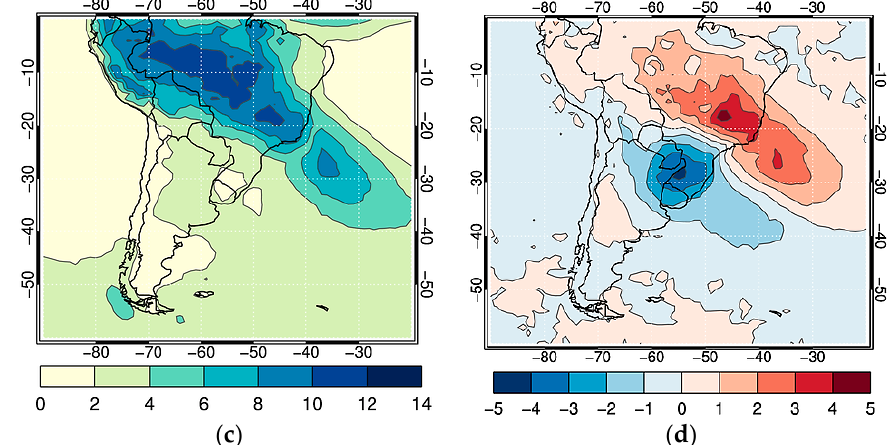
Figure 1. ( a ) Average daily precipitation (mm/day) in the SACZ events and ( b ) difference (in mm) between (a) and the average daily precipitation for October to March; ( c ) the same as (a) but for GPCP data and ( d ) the same as ( b ) but for GPCP data.